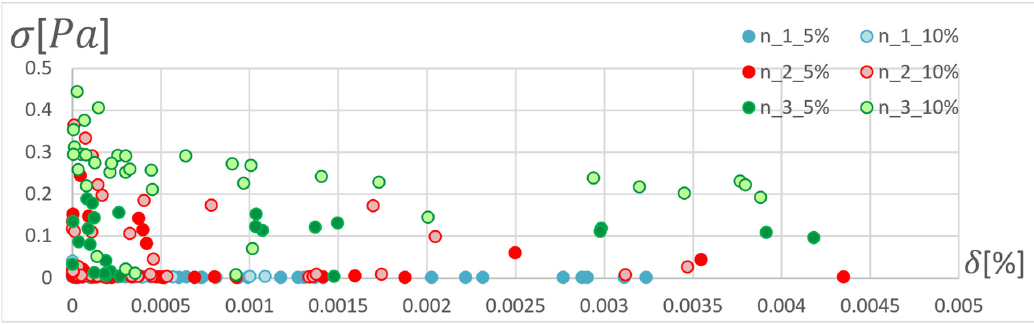
Materials 2022 , 15 , x FOR PEER REVIEW Figure 12. Pareto fronts for all networks trained using the SCG algorithm. Figure 12. Pareto fronts for all networks trained using the SCG algorithm.